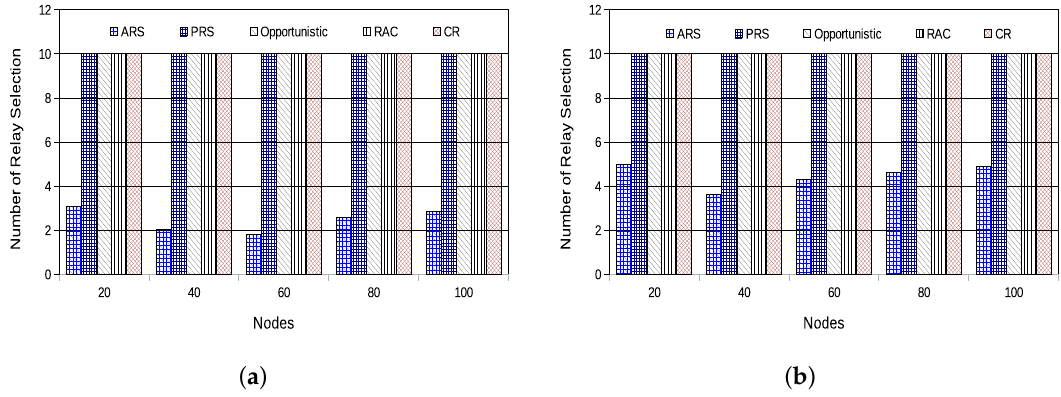
Figure 12. Average Number of Relay Selection—static topology ( a ) vs. dynamic topology ( b